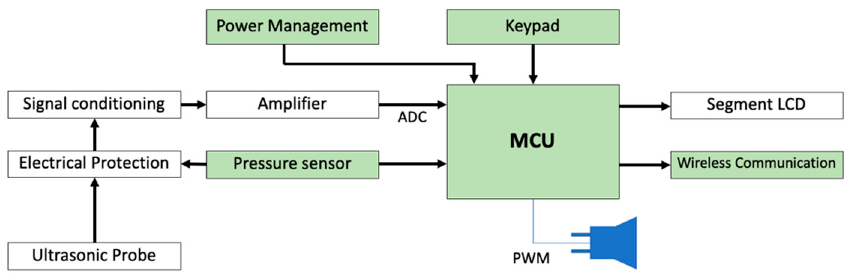
Figure 1. The general scheme of Doppler measuring instruments for heart rate.